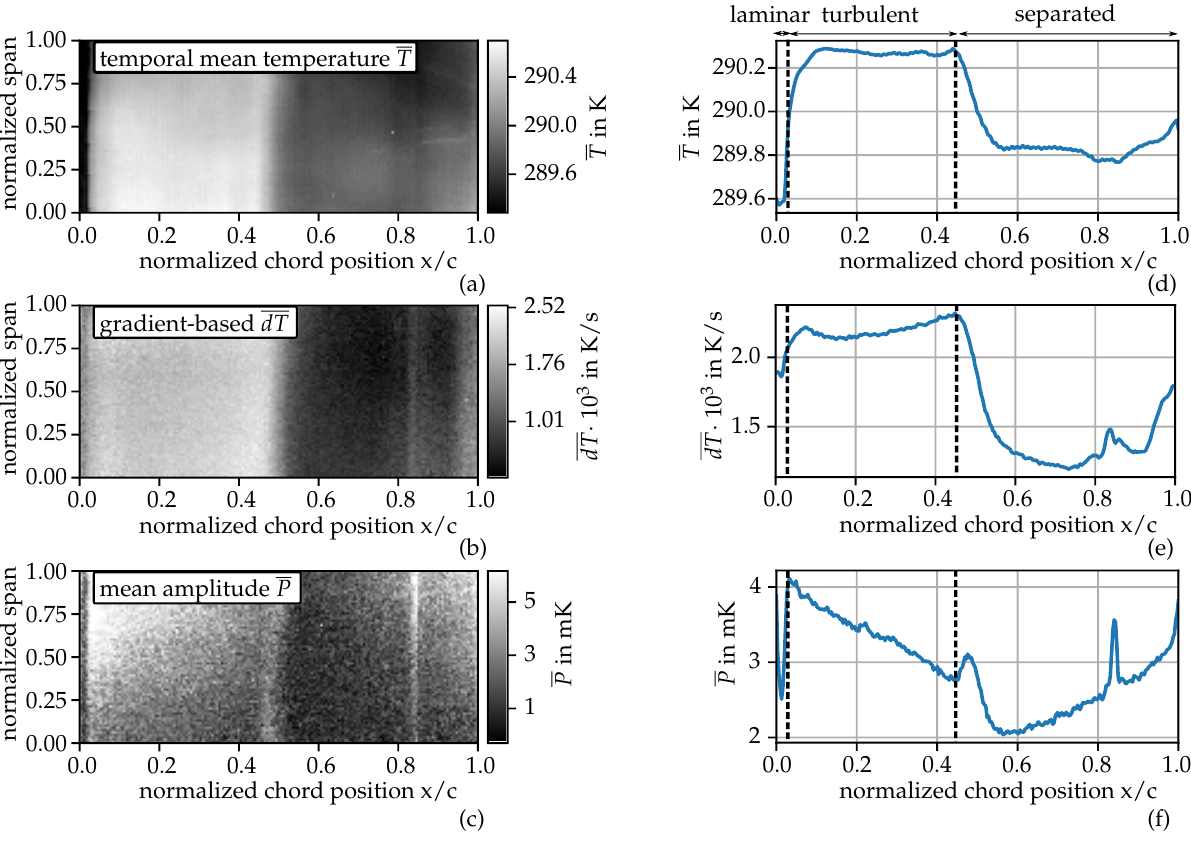
Figure 9. Comparison of the evaluation of thermographic image series by the mean temperature ( a , d ), gradient-based ( b , e ) and the harmonic signal processing approach ( c , f ) for a transient input signal. Left side ( a – c ): processed thermographic images; right side ( d – f ): averaged profiles over the normalized chord position. Experimental parameters: Re = 3 · 10 6 , AoA = 14 ◦